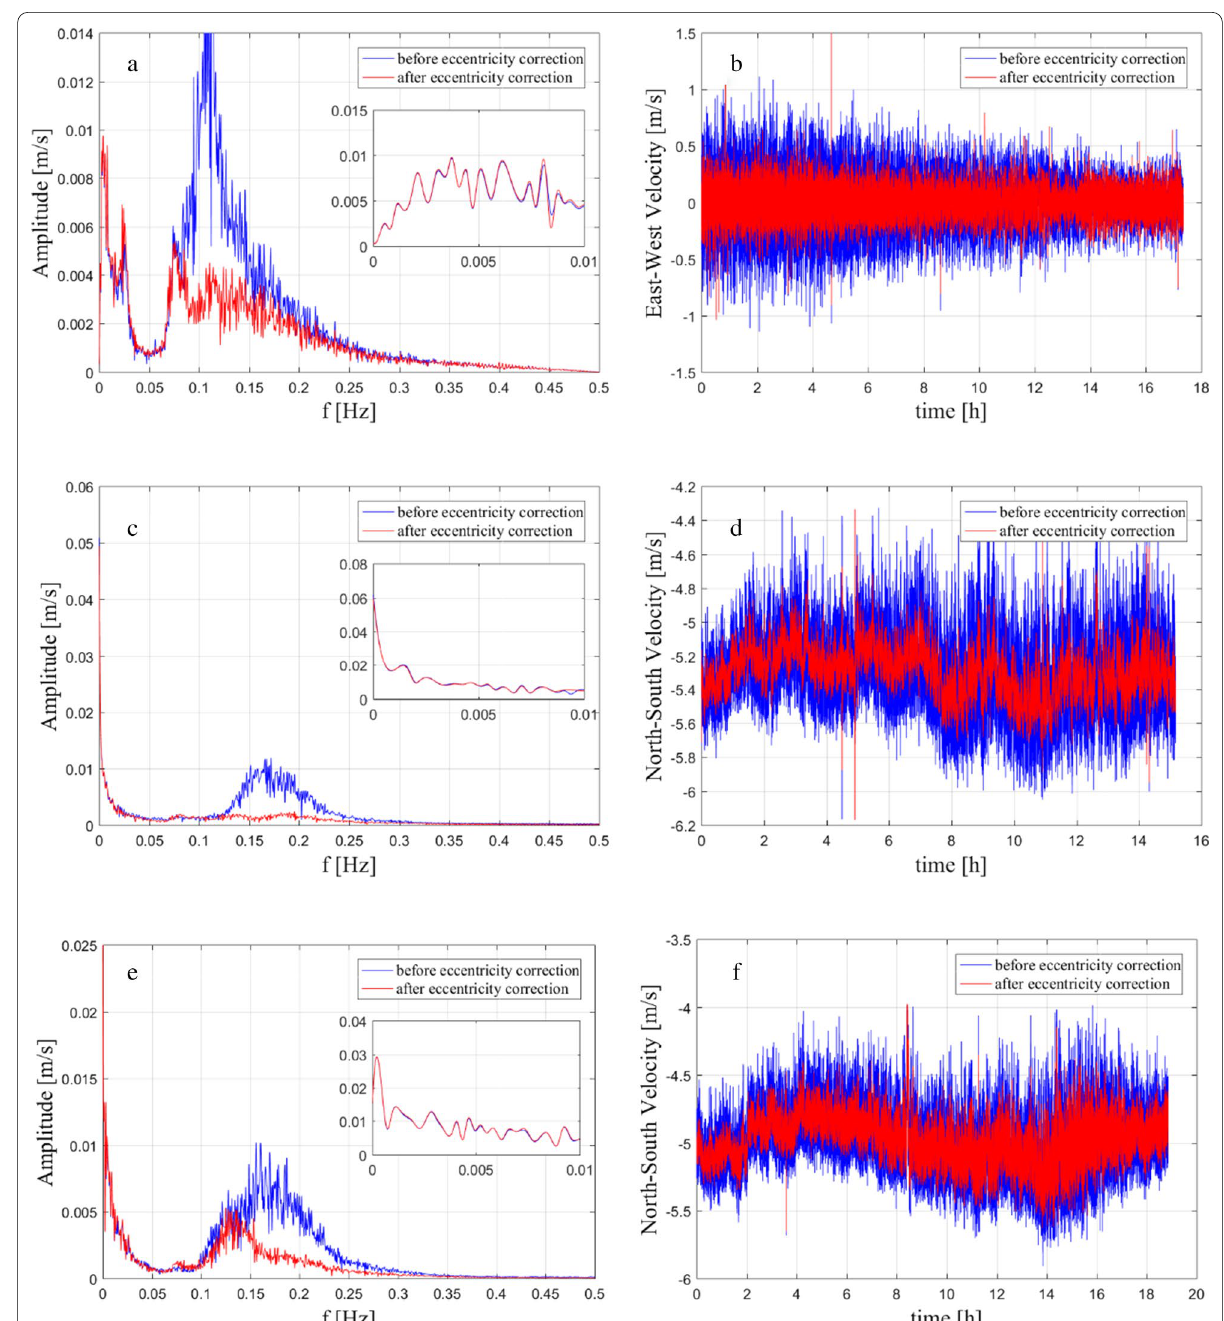
Fig. 12 Fourier time–frequency analysis of horizontal velocities. a , c and e are the single-sided amplitude spectra of the horizontal velocities of S1-2, S1-1 and X1-3, respectively; the small windows are enlarged views of the low-frequency band. b , d , and f are the corresponding time-domain horizontal